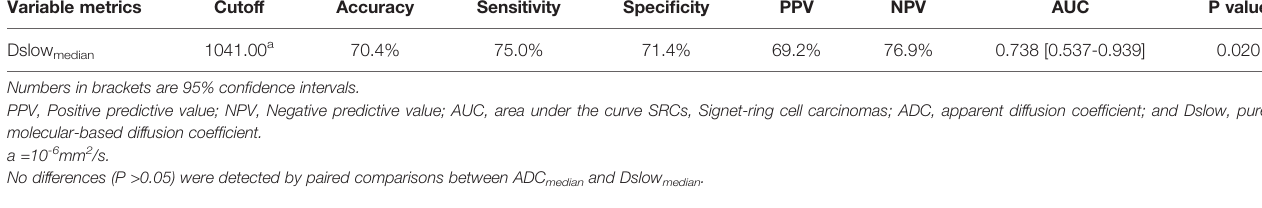
TABLE 6 | The diagnostic performance of Dslow median for discriminating SRCs and other poorly cohesive carcinomas. Variable metrics Cutoff